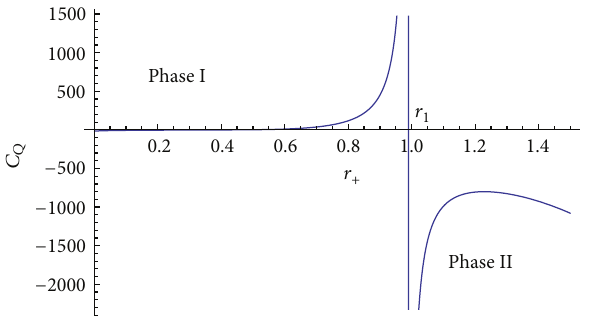
Figure 5: Plot of specific heat ( 𝐶 𝑄 ) against horizon radius ( 𝑟 + ), for 𝛼 󸀠 = 0.5 , 𝑄 = 0.50 , and 𝑏 = 10 at the critical point 𝑟